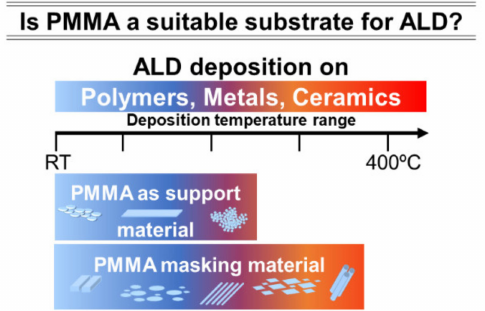
Figure 1. Schematic illustration of ALD application range: deposition temperature and types of substrates. The ability to perform ALD at low temperatures is well suitable to deal with thermally sensitive materials such as PMMA. As a support material, PMMA can be produced such as thick plates, spin-coated films, powder, nanoparticles, amongst other